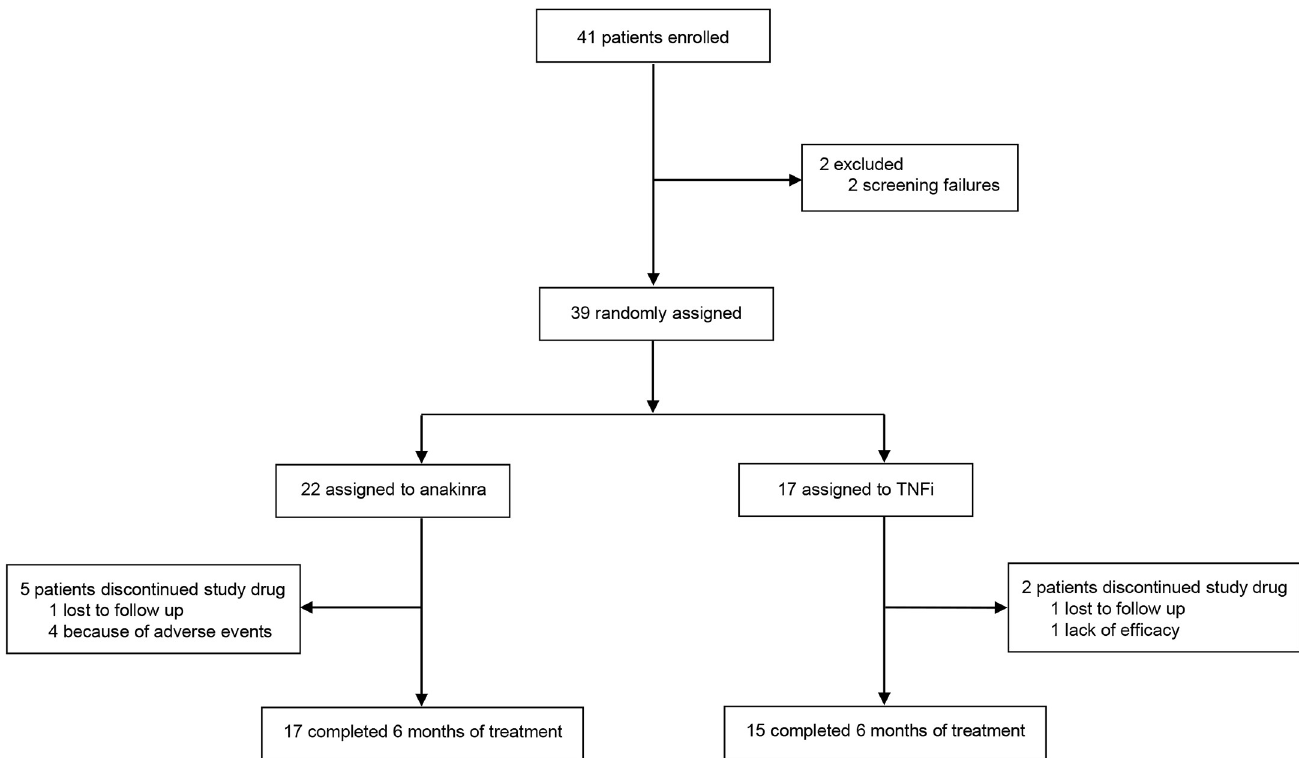
Fig 1. Trial profile. Participants were recruited from June 2013 to March 2016 and were randomised to either once-daily recombinant human interleukin- 1-receptor antagonist (100 mg of anakinra) by daily subcutaneous self-administration or TNFi administered according to relevant data sheets. TNFi, tumour necrosis factor